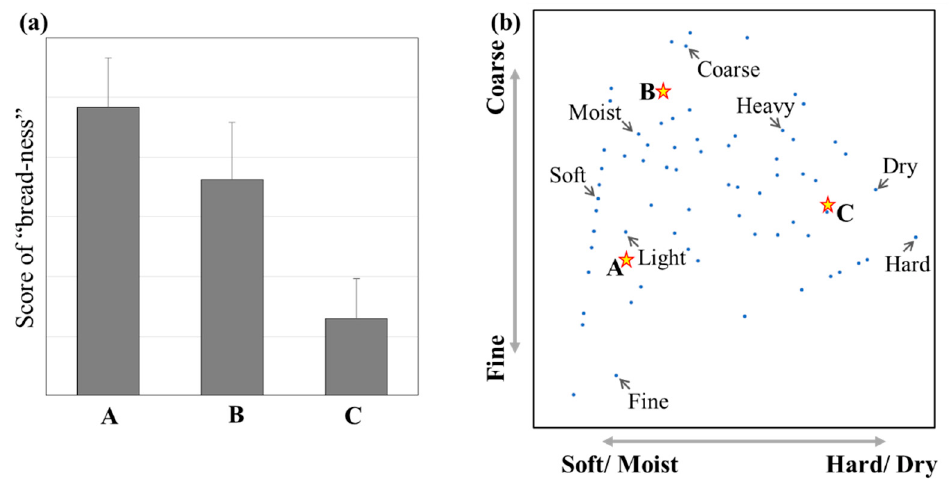
Figure 6. ( a ), Comparative diagram of “breadness” of breads A, B, and C evaluated by panelists. ( b ), Texture map of the three breads. Adapted from ref. 44 with permission.